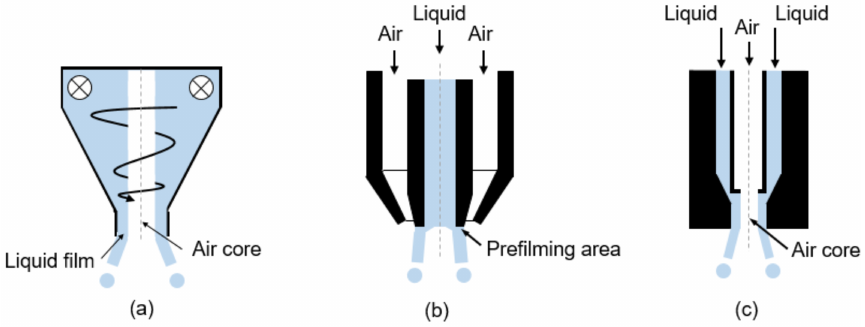
Figure 1. Schematic representation of nozzle types. ( a ) Pressure swirl atomizer; ( b ) External mixing twin-fluid atomizer; ( c ) Internal mixing twin-fluid